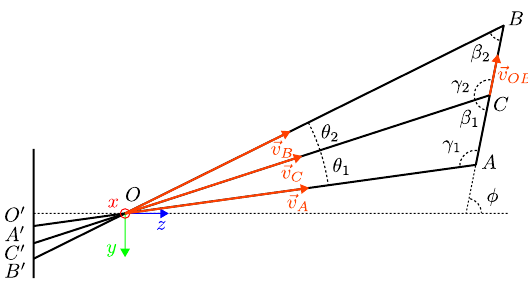
Figure 5: Target pose determination problem, projection on the yz plane of the camera frame. O is the camera optical center, C is the target center and the segment AB is the target diameter which is coplanar to the y axis. Clearly AC = BC = r